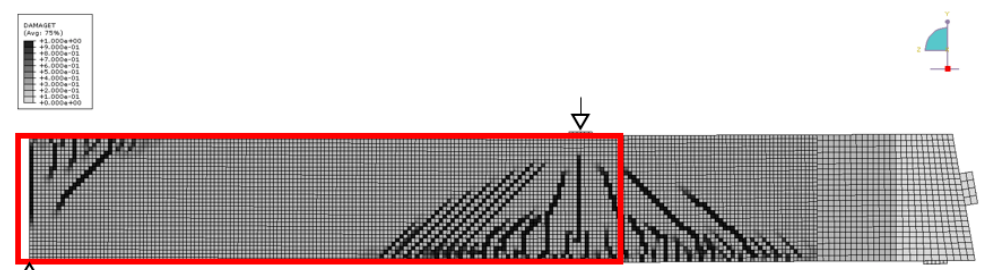
Figure 15. Girder DLT 1.3: Simulation of cracks (“damage parameter”) at 1250 kN load. Abaqus, M. Herbrand, RWTH Aachen University. Red rectangle: area displayed in Figure 12.